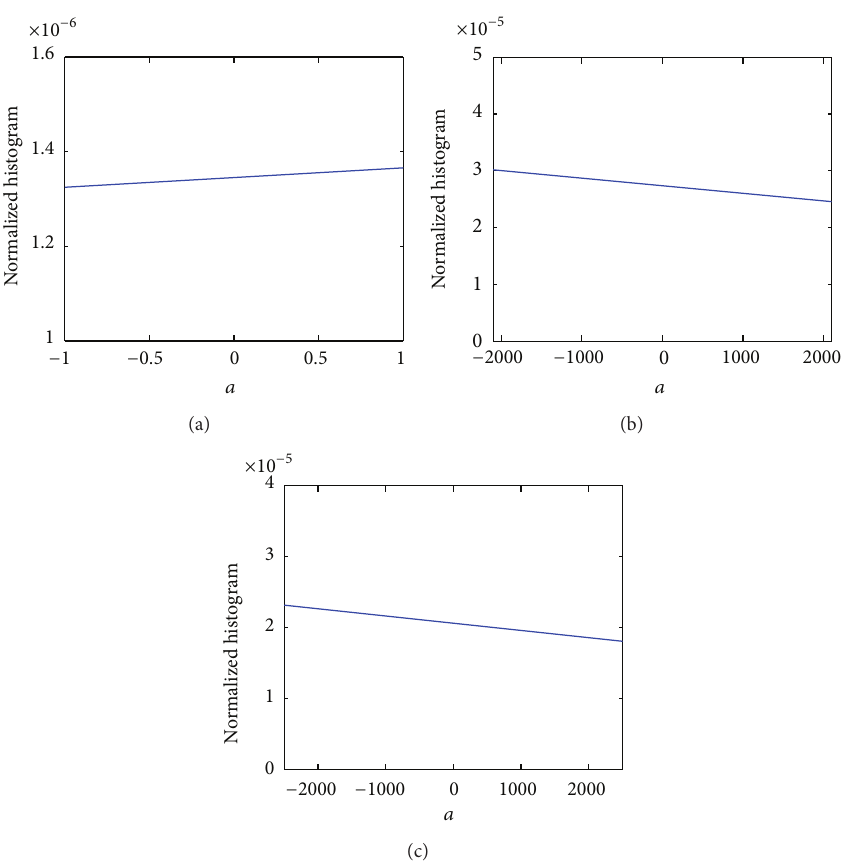
Figure 3: Normalized histogram of 𝑎 = 𝐼 𝑥 /𝐼 𝑦 for a number of image sequences commonly used in optical flow evaluations including; (a) RubberWhale (Middlebury), (b) Grove2 (Middlebury), (c) Marbled Block